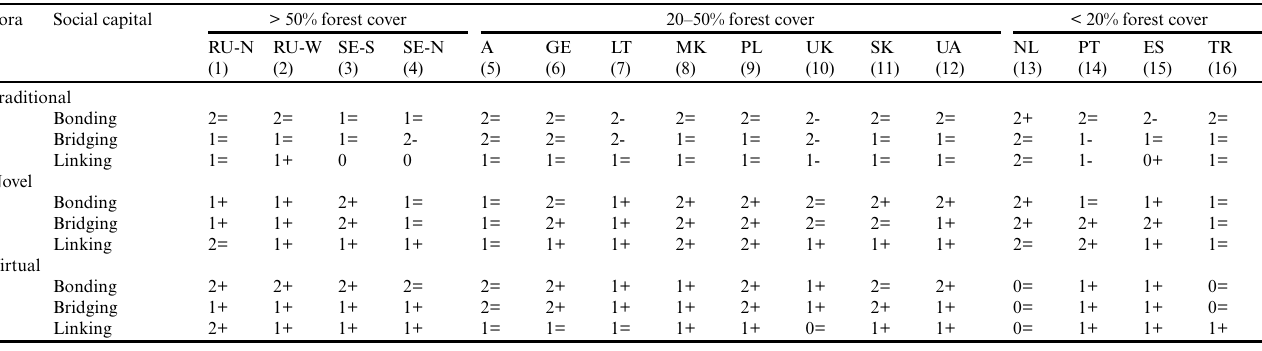
Table 3 . Overview of the hotspot areas’ social capital interactions (bonding, bridging, or linking) in each of the three groups of fora, assessing which is active (2), present (1), or (near) absent (0), and the trend from the past (before 1980s † ) to present is marked as increasing (+), stable (=), or negative (-). See Table 1 and Figures 2, 3, 4 for details about the case study regions and hotspots. The Likert ranks are shown in Figure 8. † Assuming that the 1980s is before “modern” ideas about sustainable development and sustainability appeared (Brundtland, Rio etc.).